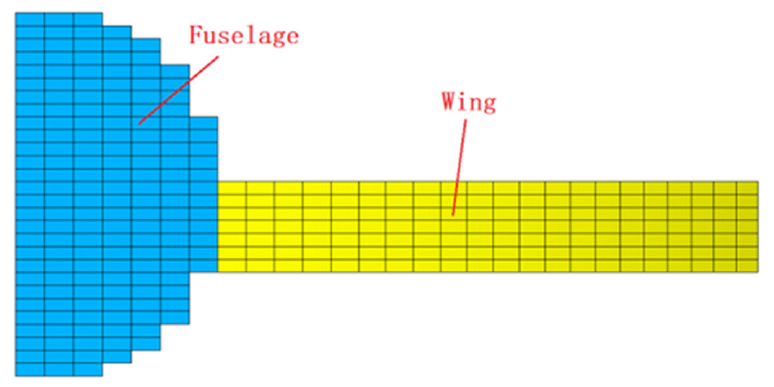
Figure 4. Crash zone of fuselage and wing.